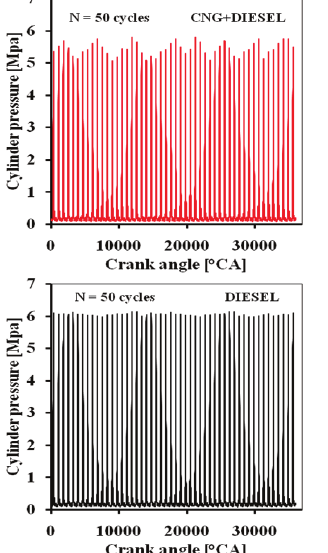
Fig. 4. Example sets of indicator diagrams determined under steady state conditions for subsequent operating cycles of Perkins 1104D-E44TA engine in dual-fuel CNG + Diesel operation and powered by diesel fuel only, operating according to the load characteristics for crankshaft speed